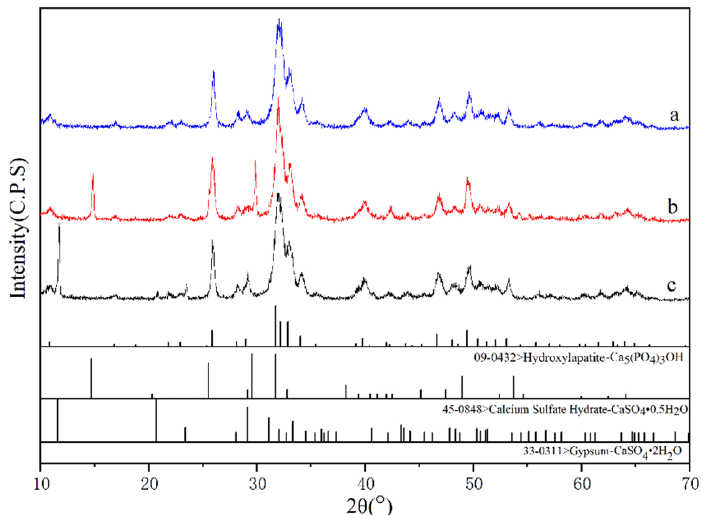
Figure 7. The XRD results of the bone samples before and after the consolidation treatment. a. Untreated, b. treated by CSH suspension, c. treated by both the CSH suspension and water.